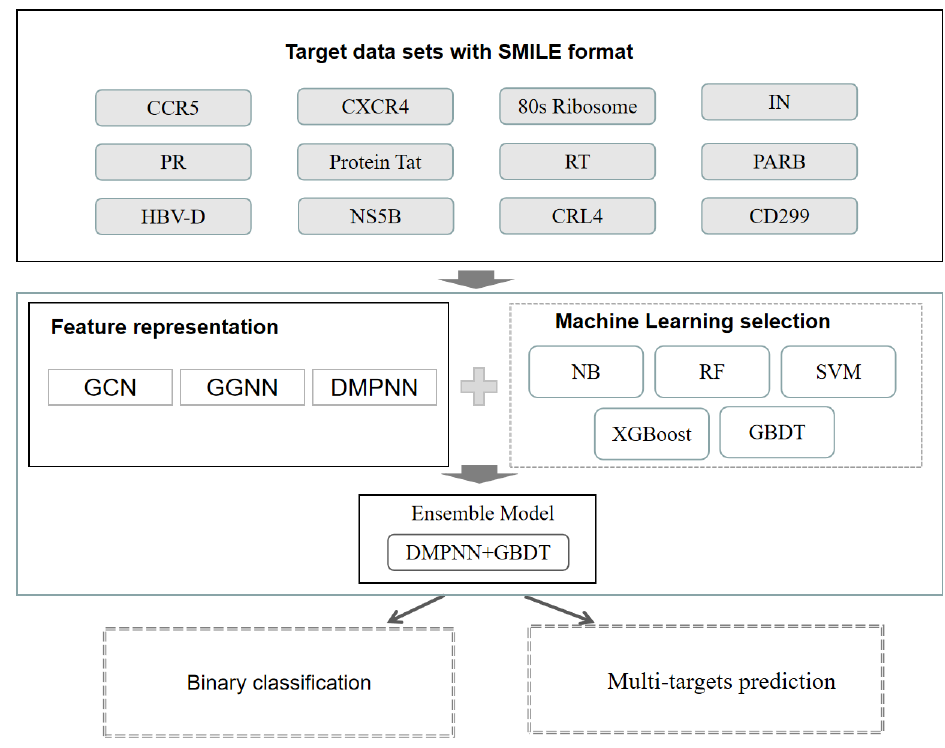
Figure 1. Workflow of our study.